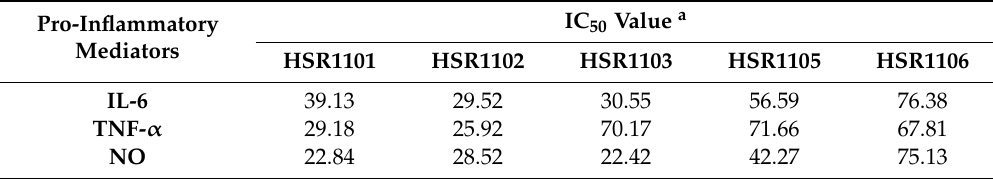
Table1. IC 50 valuesofisoquinoline-1-carboxamidederivativesinhibitingIL-6, TNF- α , orNOproduction in LPS-treated BV2 microglial